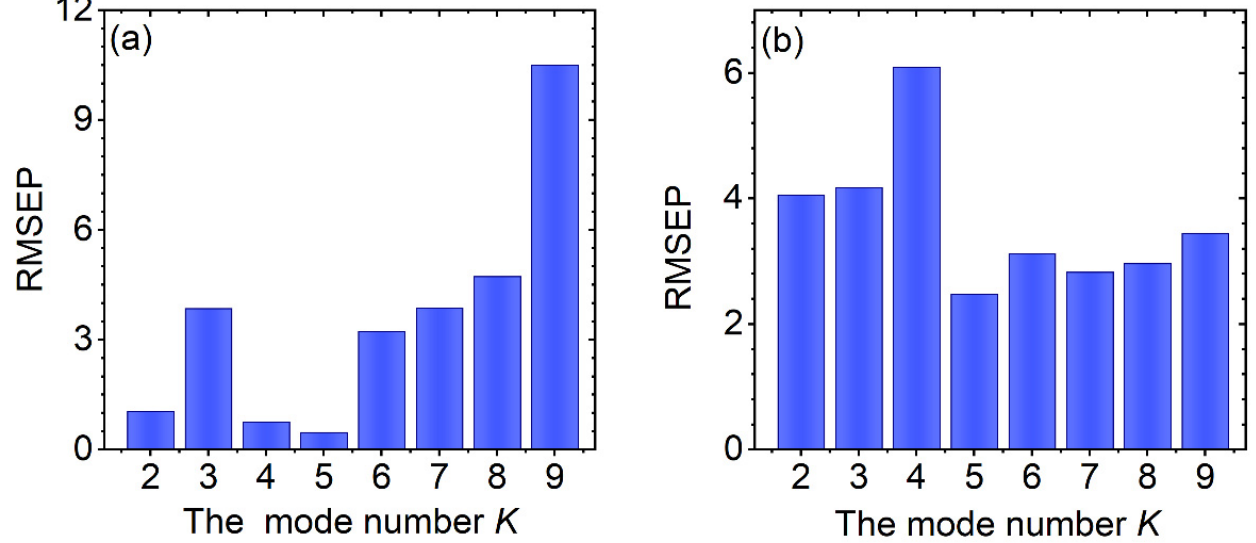
Figure 3. Variation in the RMSEP of VMD-WMSVR modeling with the mode number K for the adulterated vegetable oil ( a ) and herb ( b ) datasets.